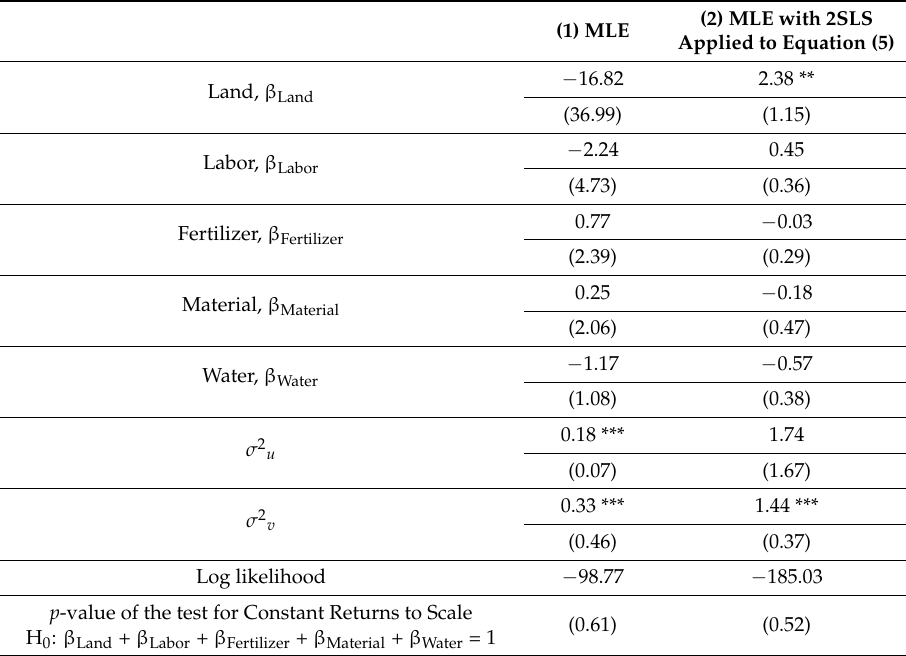
Table 2. Estimates of production function parameters.